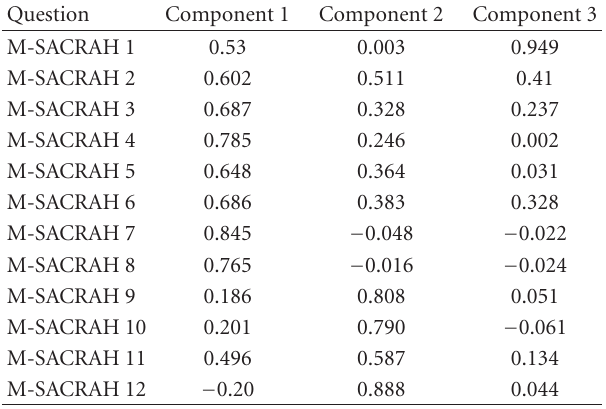
Table 6: Principal component analysis of the M-SACRAH items. Rotated component matrix (item